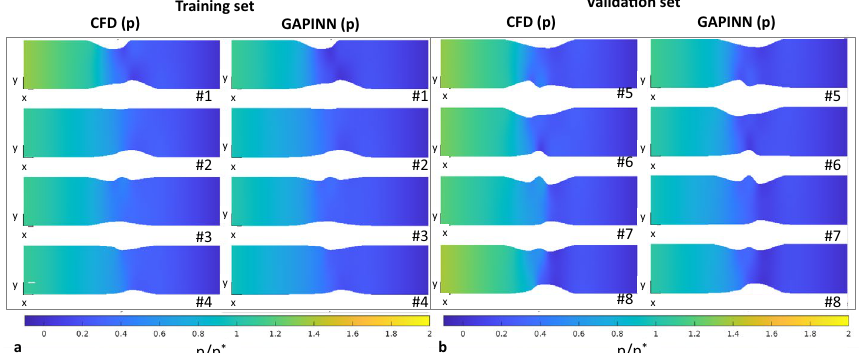
Fig. 5 Comparison between GAPINN predictions and CFD solutions on eight randomly picked samples (#1–#8) of irregular vessels from training ( a ) and validation ( b ) with velocity in streamwise component u on the left and spanwise velocity component v on the right